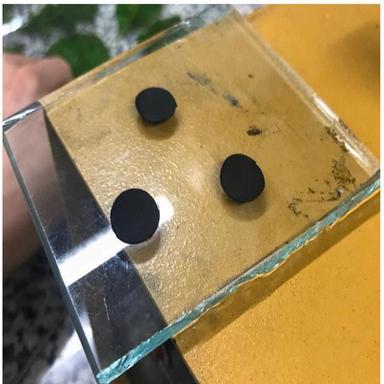
Electrodes after kneading and before baking.